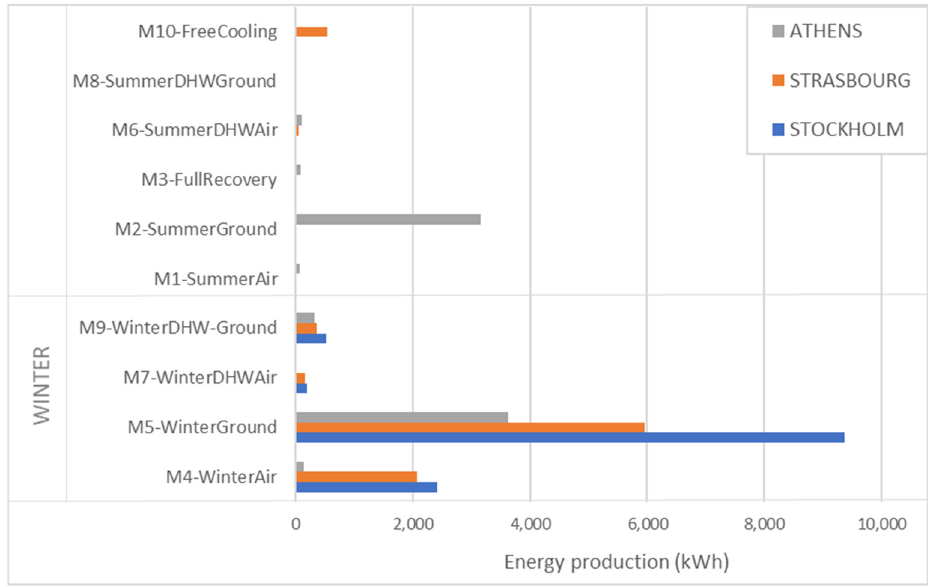
Figure 10. The energy produced in different operating modes (15th year of operation).